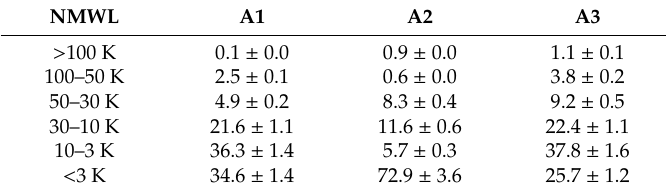
Table 3. PAC distribution in commercial cranberry extracts (A1–A3). The relative percentages of PACs were determined by DMAC assays after fractionation by molecular sieves. Values are reported as averages ±